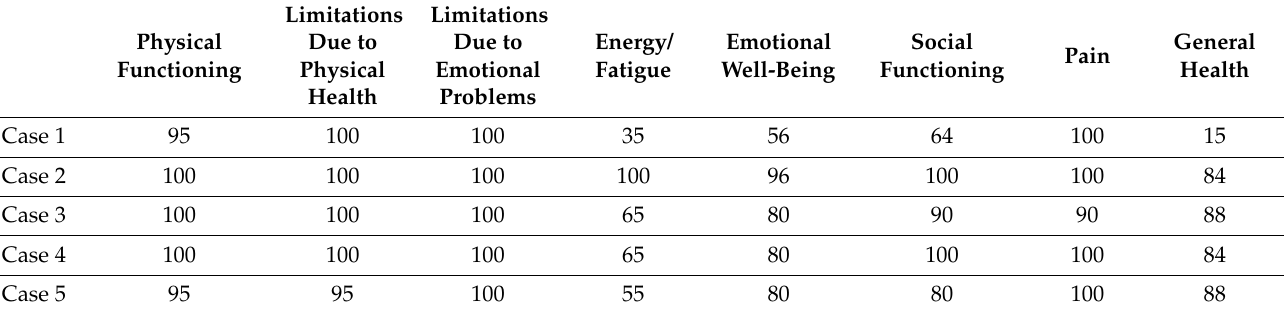
Table 3. Outcomes of the SF-36 QOL